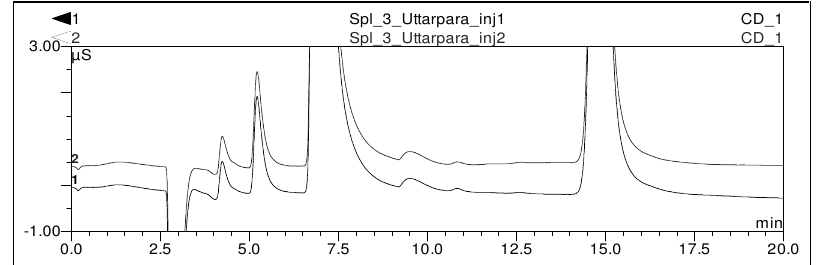
Figure 7. Electrochemical (amperometry) detection of sample_Uttarpara for arsenite content (duplicate injections)